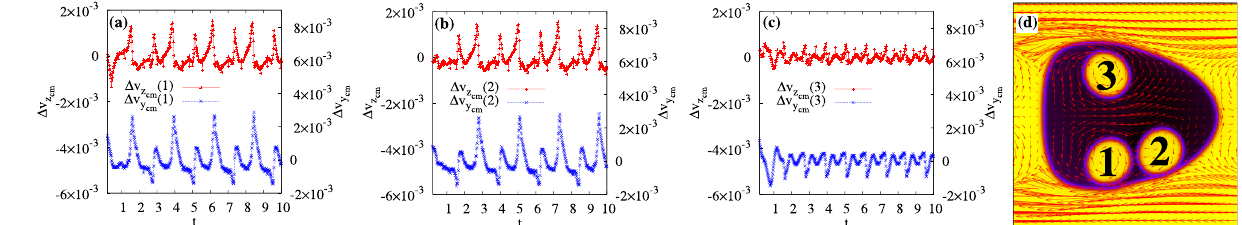
(red/plusses) and Δ v y (blue/crosses) of the cores, cm cm